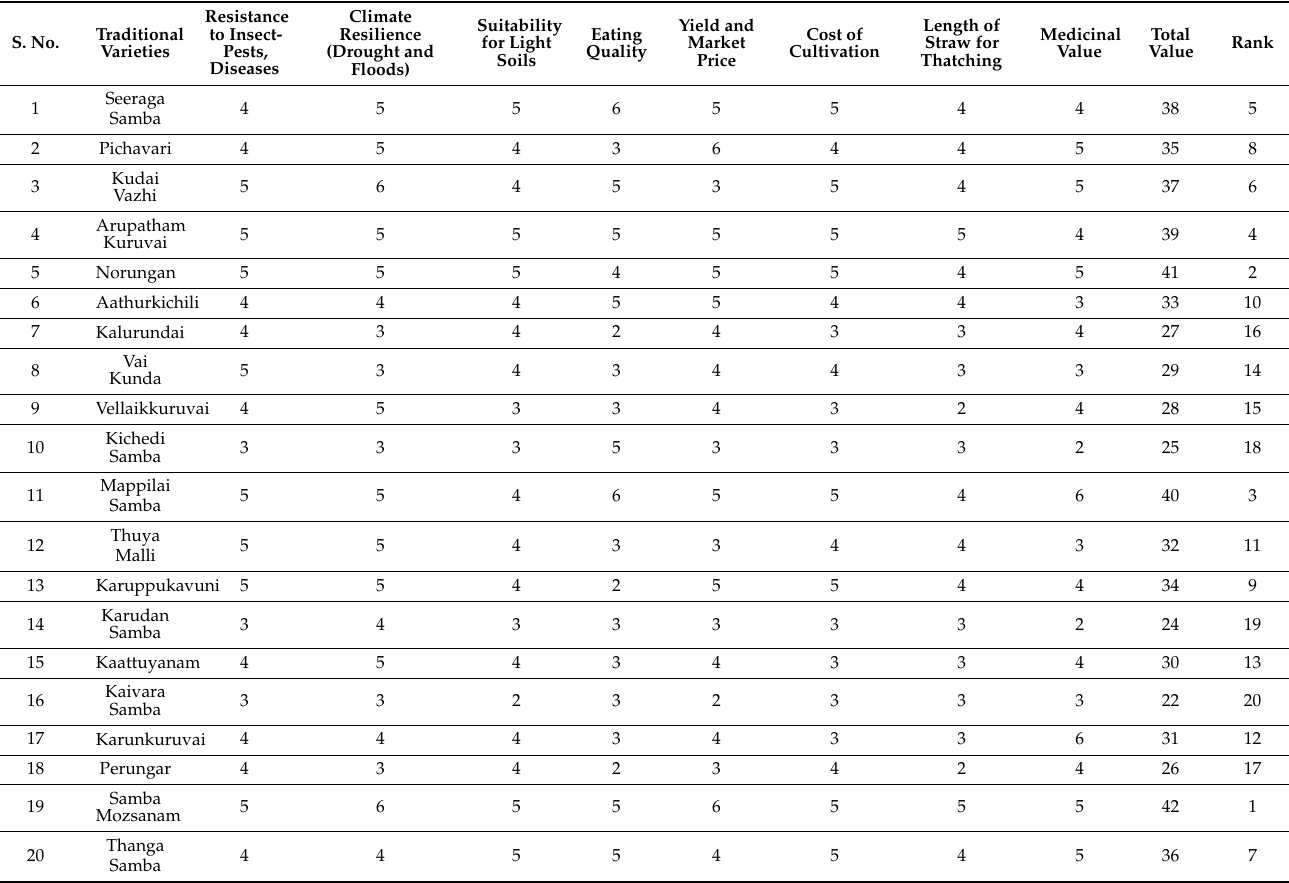
Table 7. Matrix Ranking of Traditional Rice Varieties of Eastern Coastal Region of Tamil